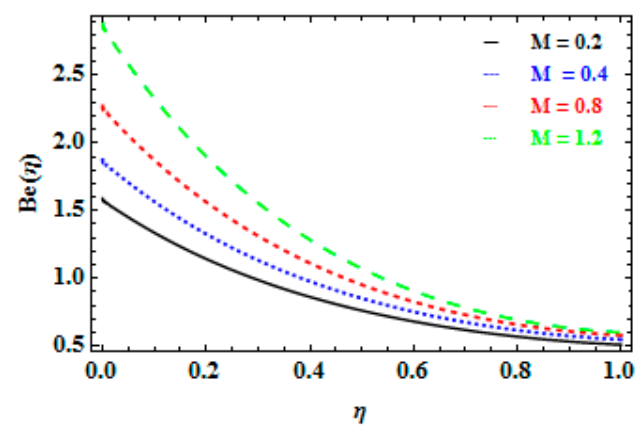
Figure 20. Influence of M on Be( 𝜂 ) .